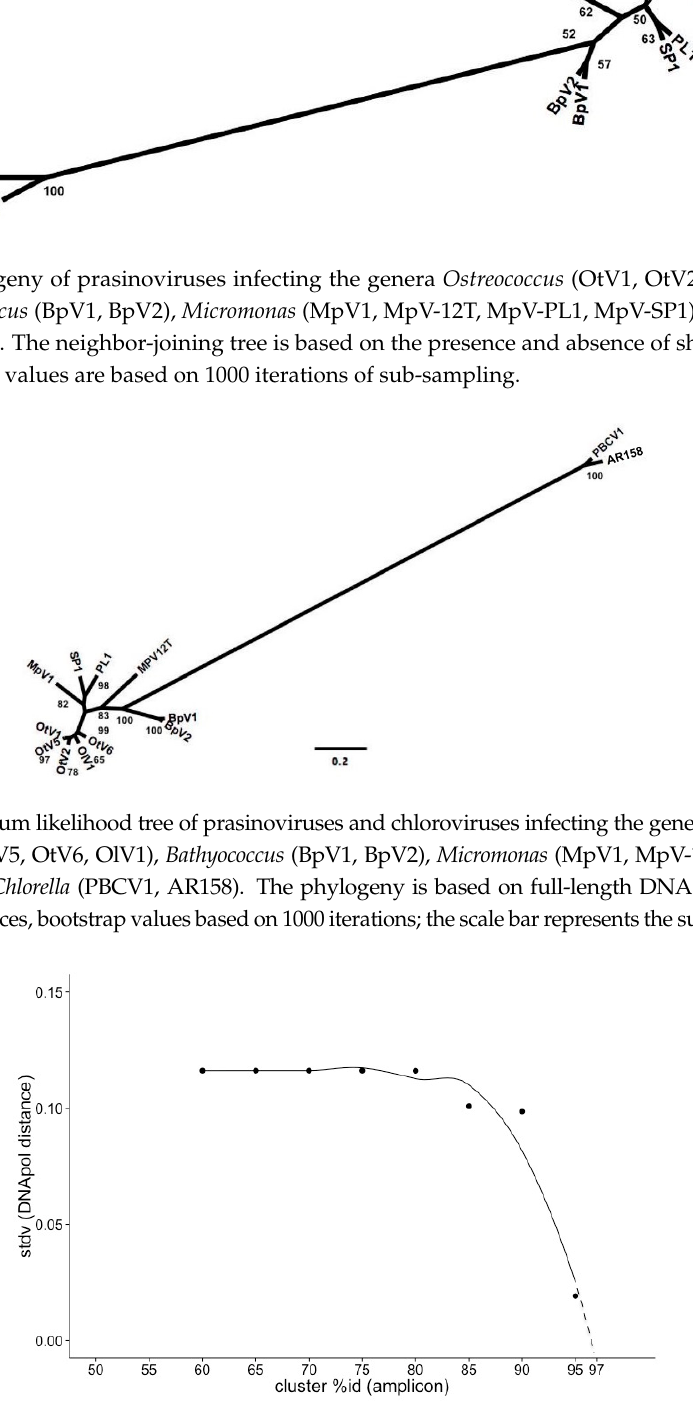
genes. Bootstrap values are based on 1000 iterations of sub ‐ sampling.